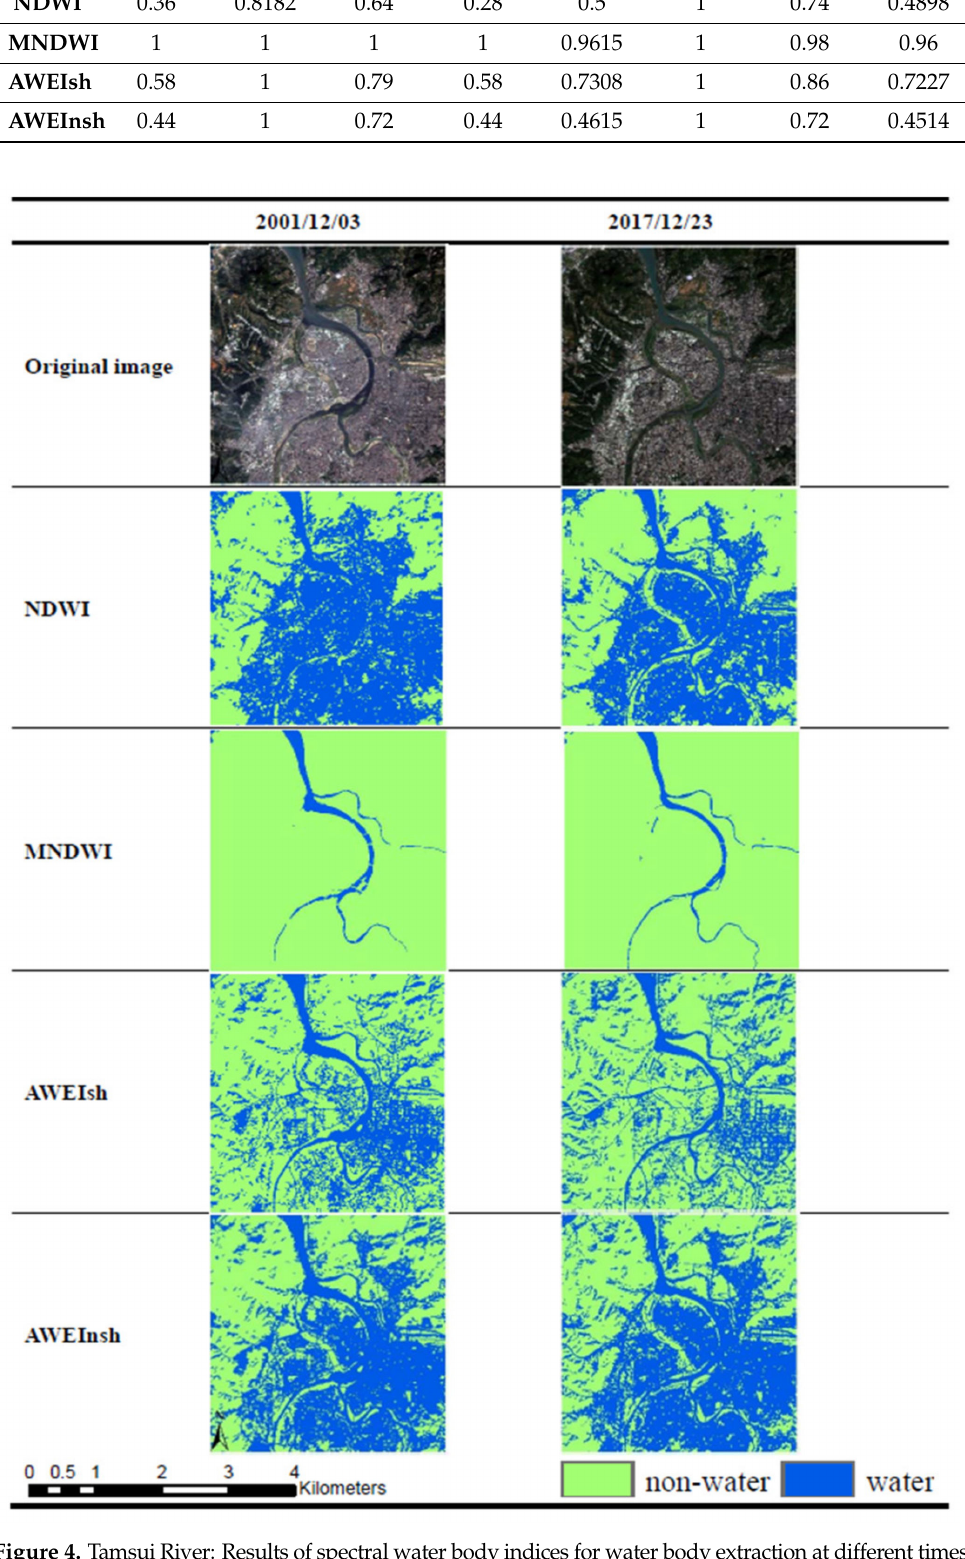
Figure 4. Tamsui River: Results of spectral water body indices for water body extraction at different